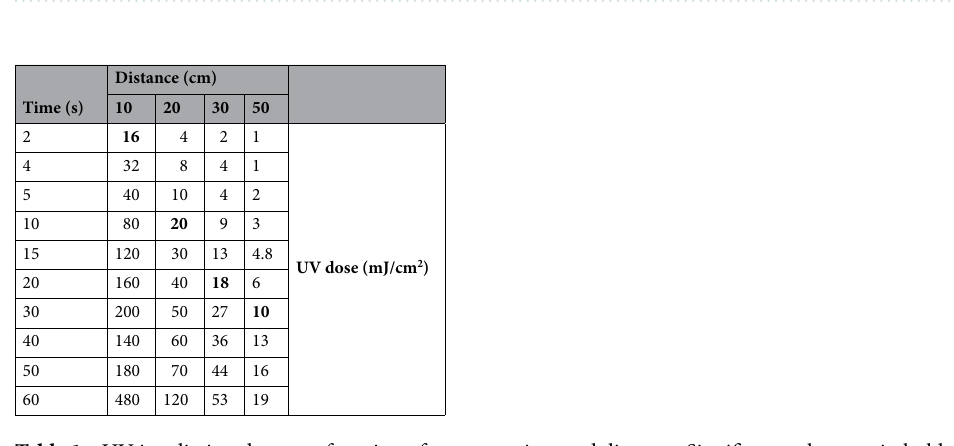
Table 1. UV irradiation dose as a function of exposure time and distance. Significant values are in bold.